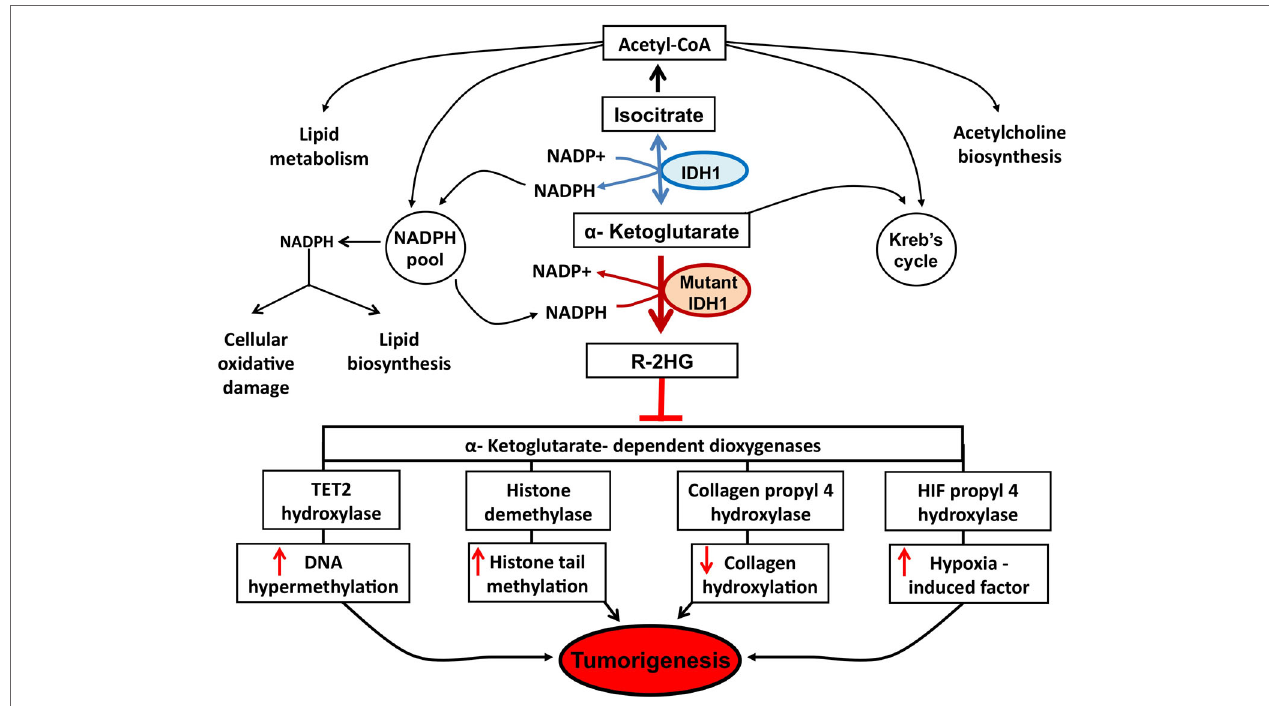
FiGURe 1 | Potential mechanisms implicated in tumor formation induced by iDH1 mutation. A number of potential mechanisms have been proposed to explain how R-2-HG produced by mutant IDH1 enzyme promotes tumor formation. Epigenetic modification, via inhibition of α -KG-dependent dioxygenases leading to DNA and histone hypermethylation, has been at the forefront of research efforts. Specifically, the inhibition of tet methylcytosine dioxygenase 2 (TET2) leads to increased DNA hypermethylation and the inhibition of histone demethylases leads to increased histone tail methylation. Additional mechanisms include inhibition of several groups of prolyl hydroxylases, leading to hypoxia-induced factor (HIF) activation and alterations in collagen